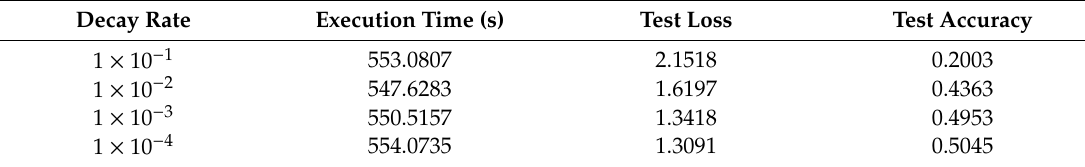
Table 14. E ff ect of learning rate decay on RNN.